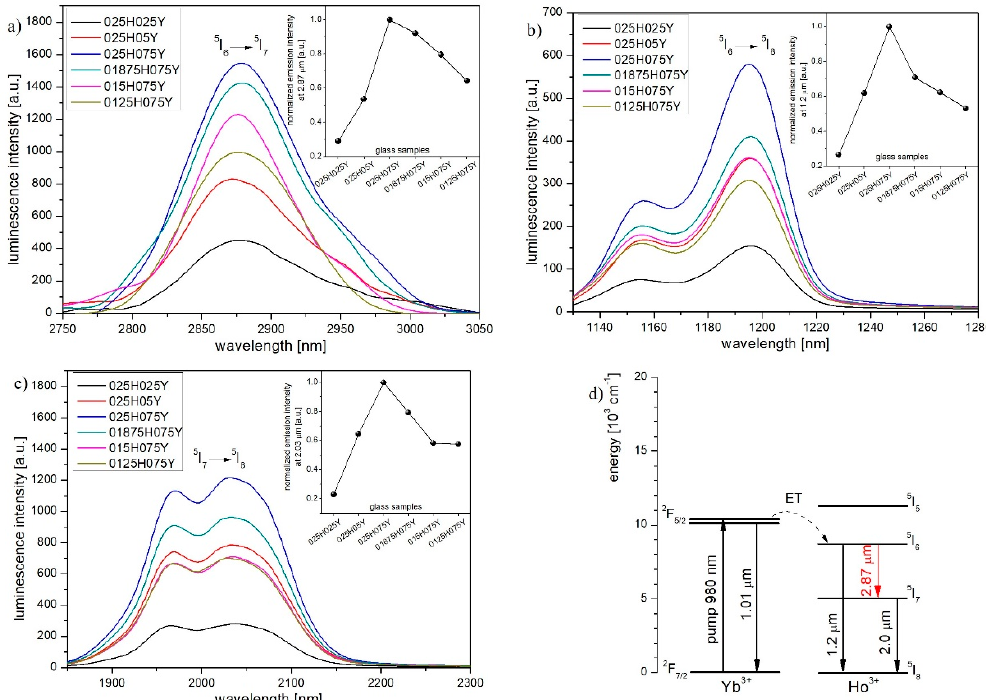
Figure 6. Luminescence spectra of fabricated glasses and normalized emission intensity (insets) in ( a ) ( a ) 2.87 µ m, ( b ) 1.2 µ m, ( c ) 2.03 µ m wavelength bands and ( d ) simplified Ho 3 + / Yb 3 + energy level 2.87 µm, ( b ) 1.2 µm, ( c ) 2.03 µm wavelength bands and ( d ) simplified Ho 3+ /Yb 3+ energy level diagram diagram with energy transfer with energy transfer mechanisms.